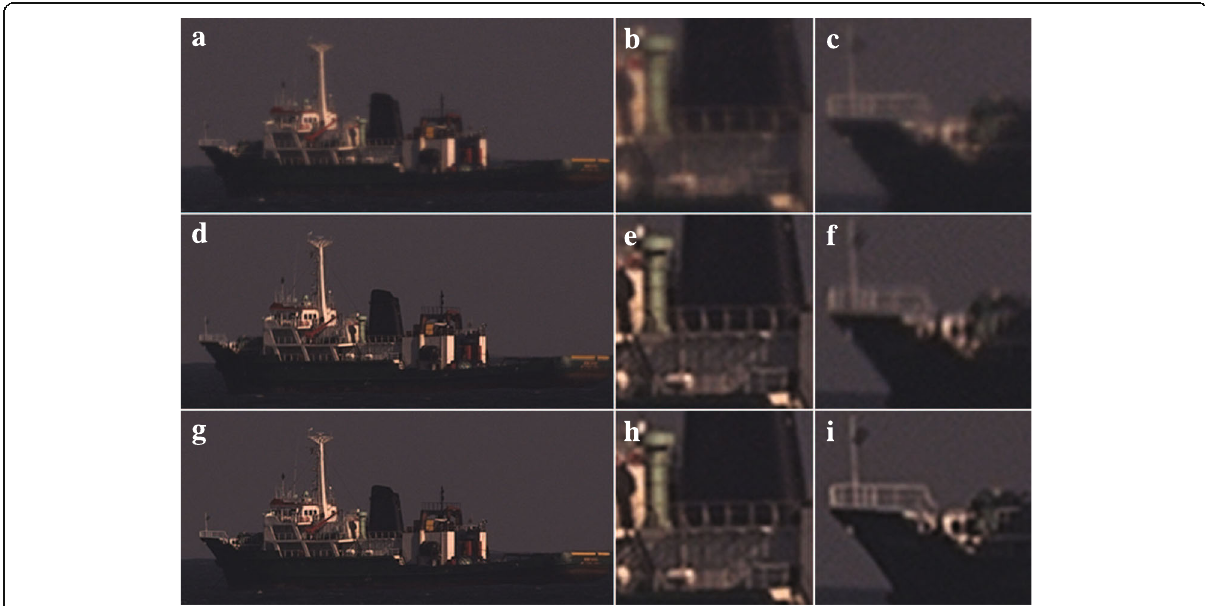
Fig. 3 Turbulence mitigation on ship at sea. The ship is about 550 × 210 pixels in size. The top row shows a still from the raw video ( a ) with enlarged cut-outs on the center ( b ) and bow ( c ) of the ship. The middle row ( d - f ) shows the results for our turbulence mitigation method from Dijk et al. [16] and the bottom row ( g - i ) for the proposed dynamic turbulence mitigation with Lucas-Kanade flow respectively